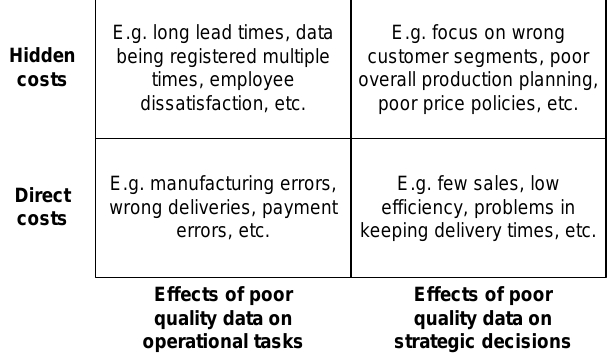
Figure 2. “Four types of costs incurred by poor quality